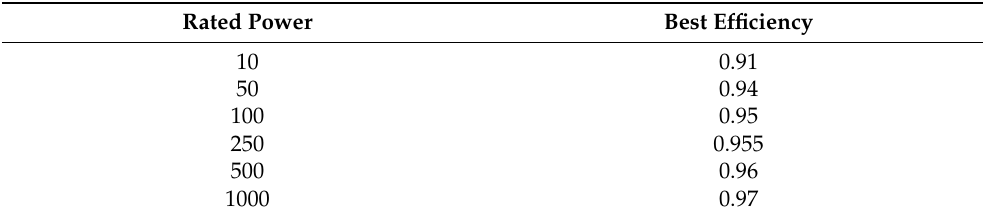
Table 5. Typical efficiencies of small generators